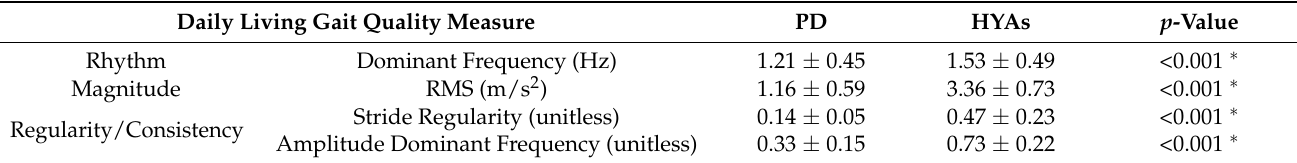
Table 6. Daily living gait quality measures in people with PD and healthy adults (HYAs).